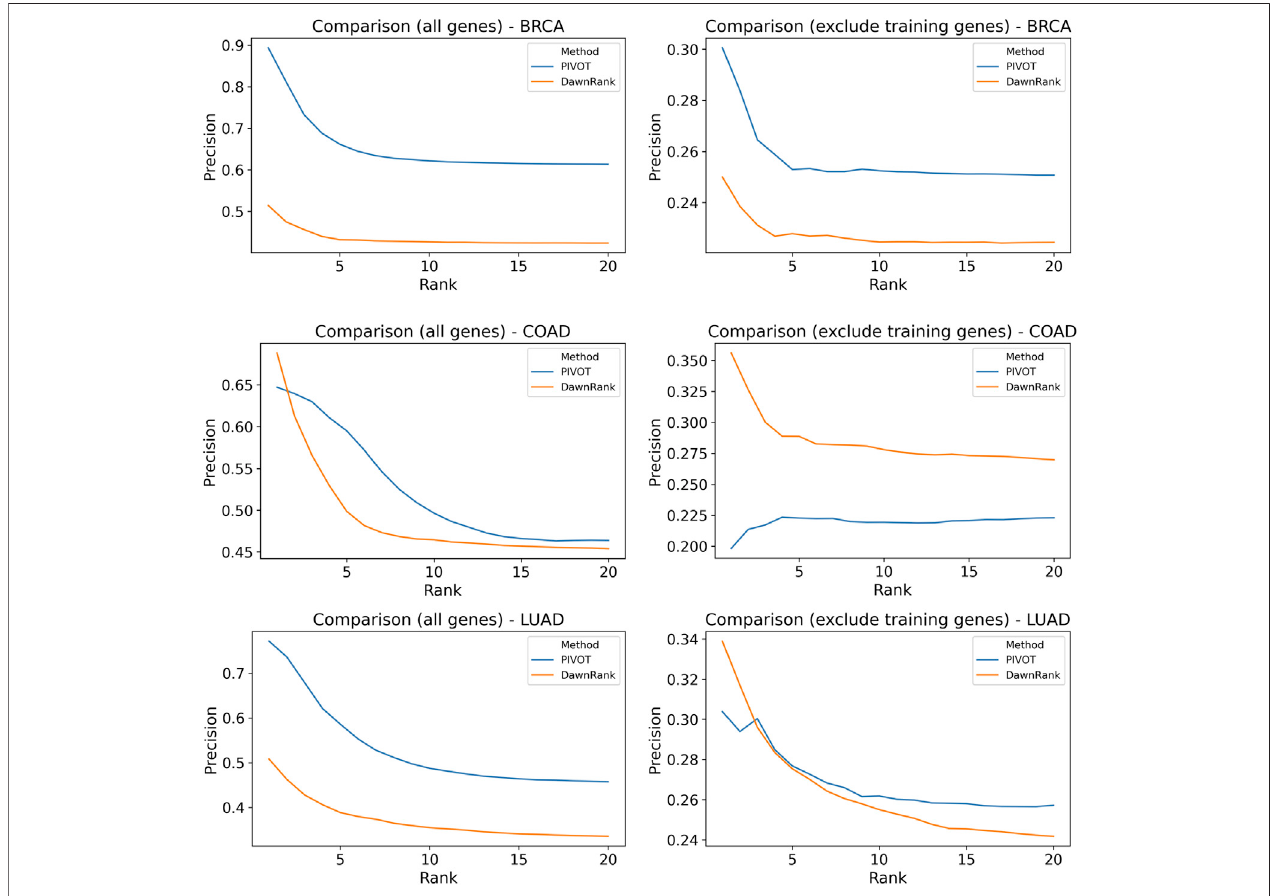
FIGURE 6 | Comparison of precision of personalized driver genes. Average precision of DawnRank and PRODIGY for varying ranks are plotted for BRCA, COAD, and LUAD. The plots ofthe left include predictions on all genesfor both methods. The plots on the right drop genes used for training PRODIGY for both methods before ranking. The precision is calculated for CGC gene